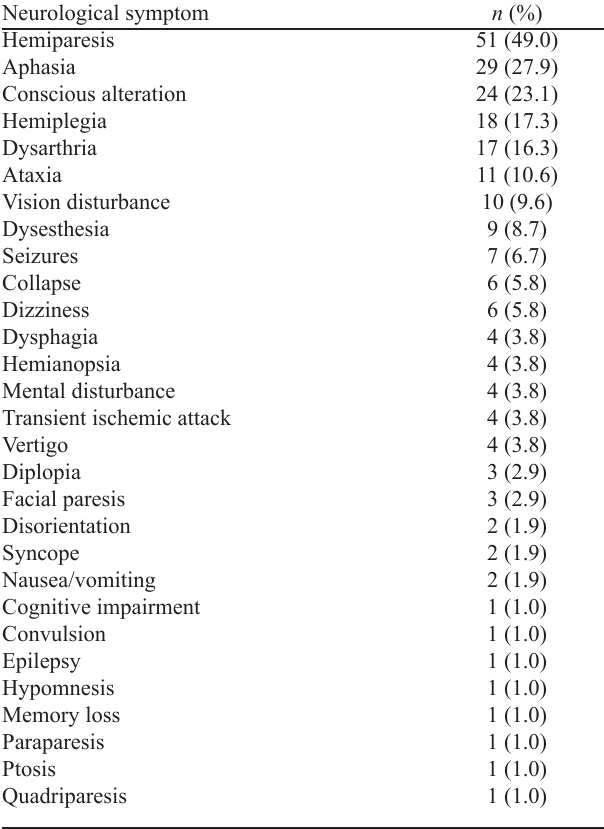
Table 1. 228 neurological symptoms in 104 patients.